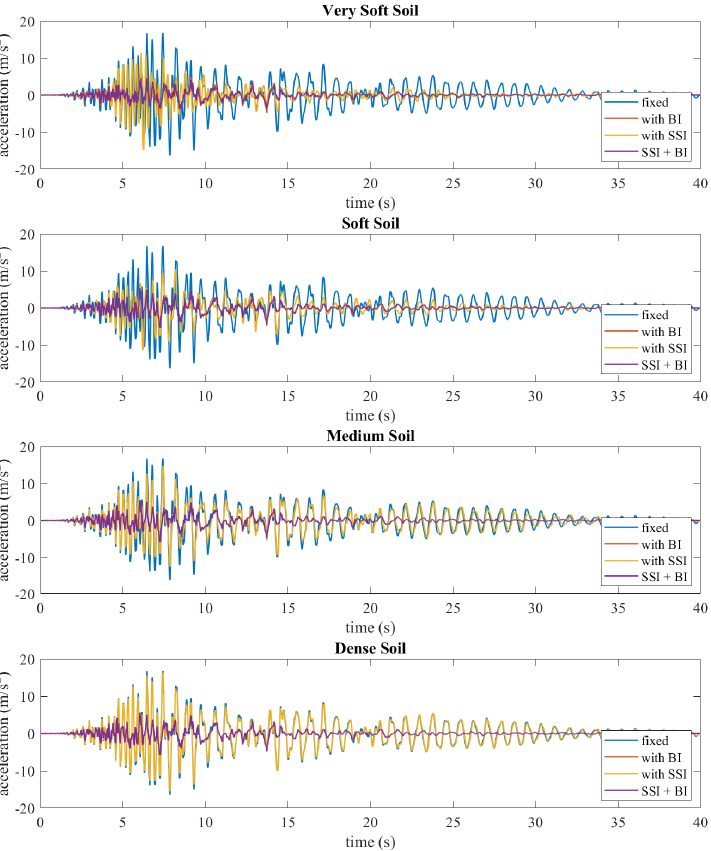
Buildings 2023 , 13 , x FOR PEER REVIEW Figure 5. Top story acceleration–time history of five ‐ story buildings (Loma Prieta, 1989). Figure 5. Top story acceleration–time history of five-story buildings (Loma Prieta, 1989).